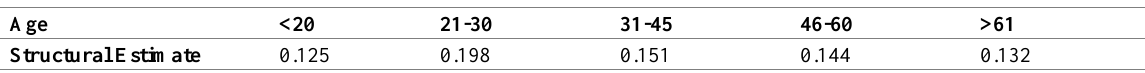
Table 7: Regression weights of the relationship among age, return process experience post-purchase regret at shopping malls in Sri Lanka